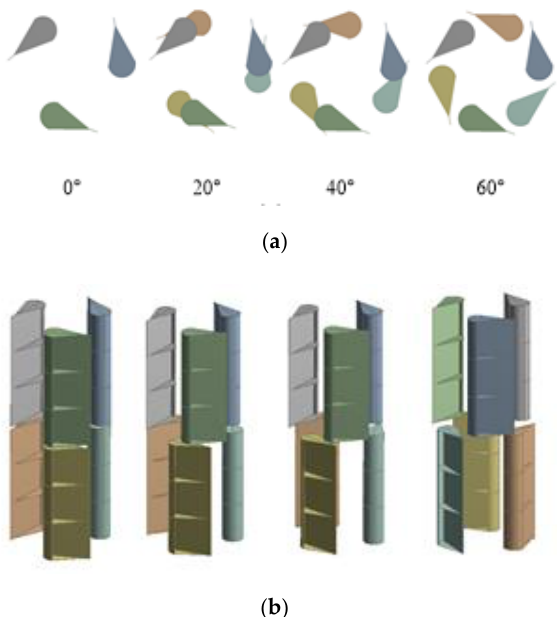
Figure 17. Stagger angles of two wind wheel layers. ( a ) Top view of different stagger angles. ( b ) Three-dimensional model of different stagger angles.